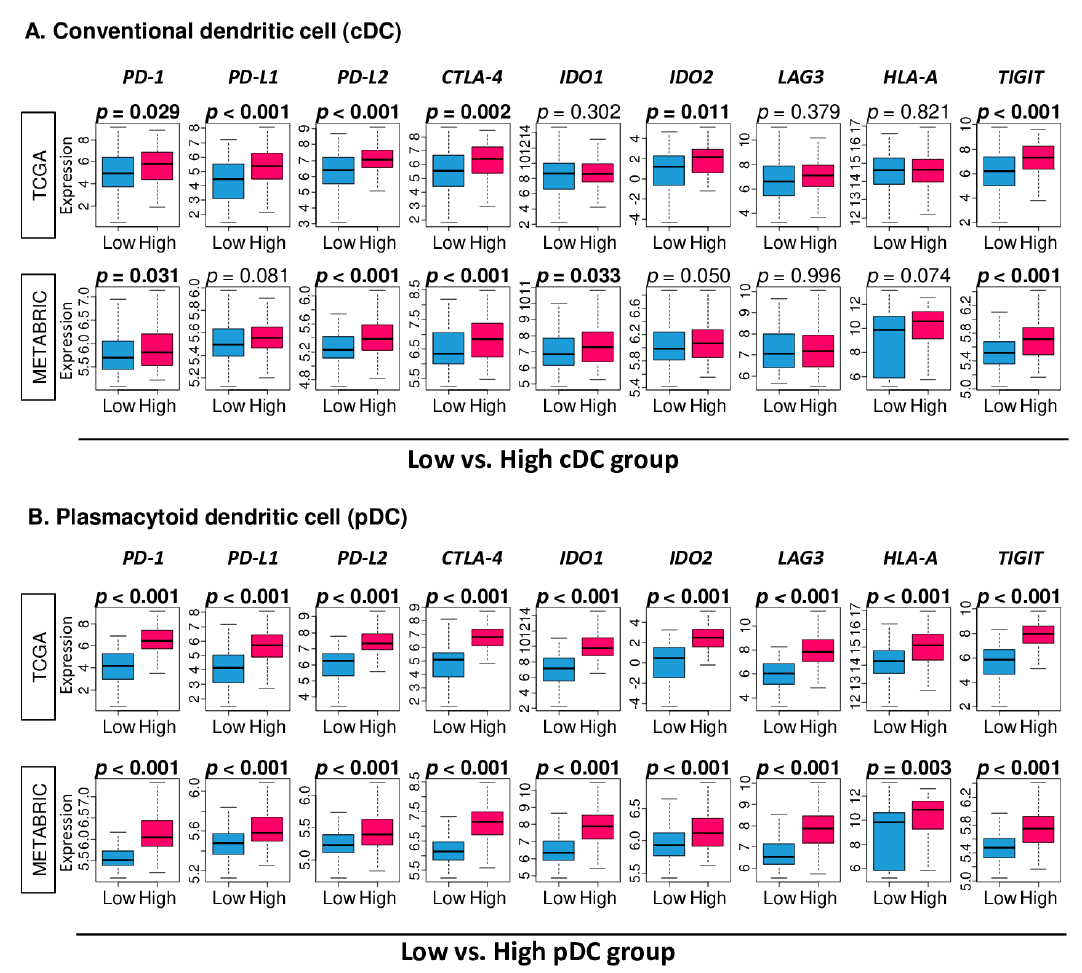
Figure 6. Association between the cDC or pDC and expression of immune checkpoint molecules in the TCGA and METABRIC cohorts. Blue and red boxes stand for low and high cDC or pDC groups, respectively. Gene expression levels of PD-1 , PD-L1 and L2 , CTLA4 , IDO1 and 2 , LAG3 , HLA-A , and TIGIT of ( A ) cDCs and ( B ) pDCs. One-way ANOVA test was used to calculate p values.